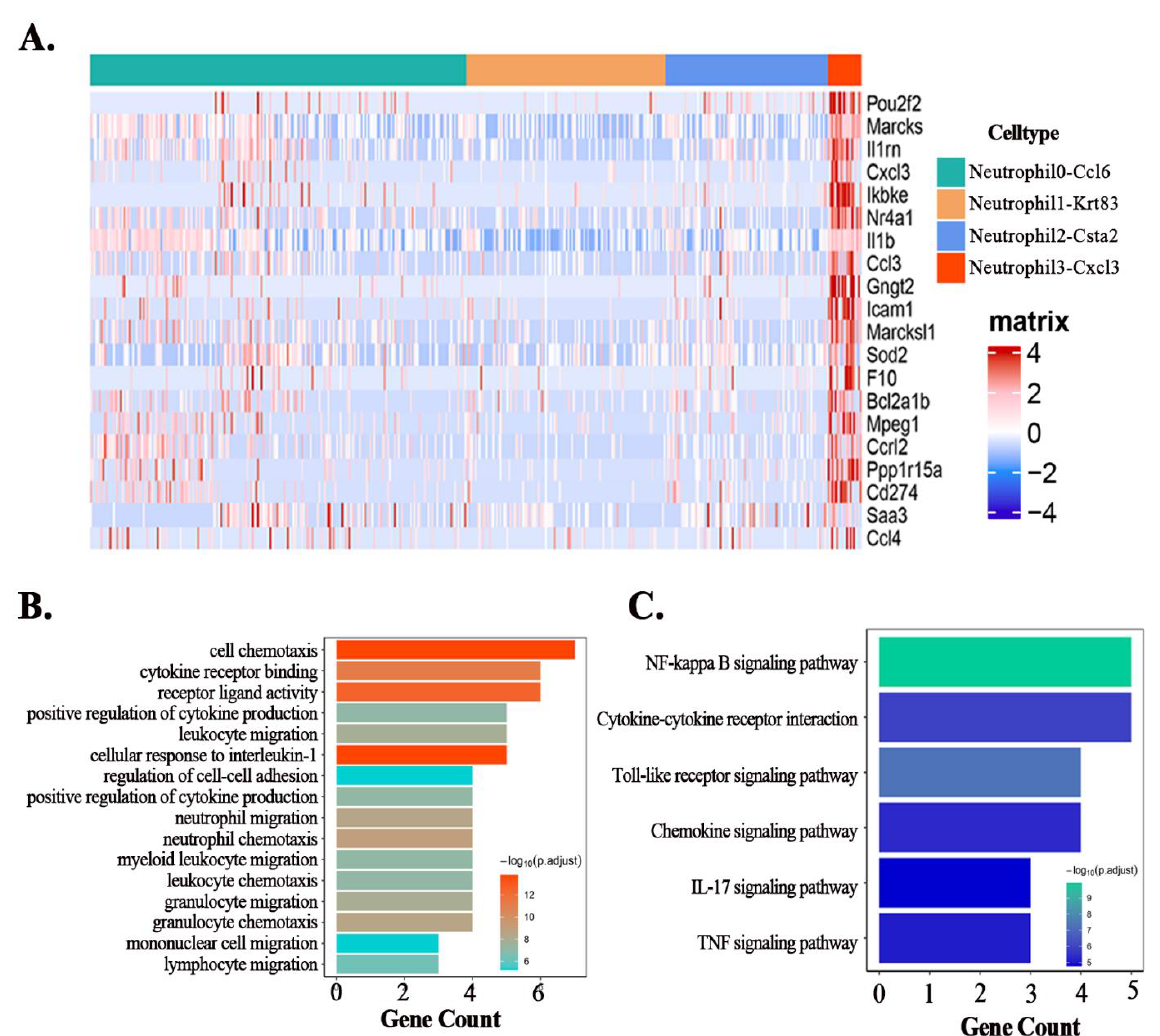
Figure 3. The DEGs and functional analysis of Neutrophil-cxcl3 subpopulation. ( A ): The heat map of the expression levels of the top20 DEGs of the Neutrophil-cxcl3 subpopulation. ( B ): The Go enrichment analysis of the DEGs of the Neutrophil-cxcl3 subpopulation. ( C ): The KEGG enrichment analysis of the DEGs of Neutrophil-cxcl3 subpopulation.